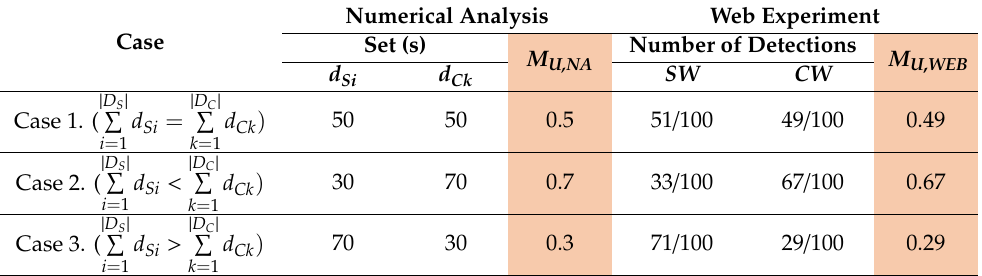
Table 5. M U , NA and M U , WEB